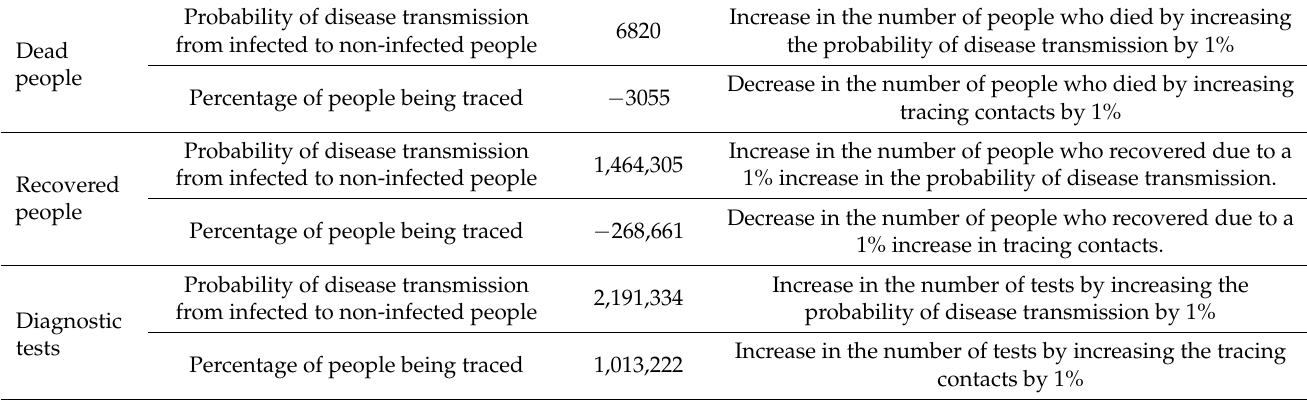
Table 5. Estimated sensitivity using response surfaces. Disease control measures: tracing and social control measures. Probability of disease Dead people